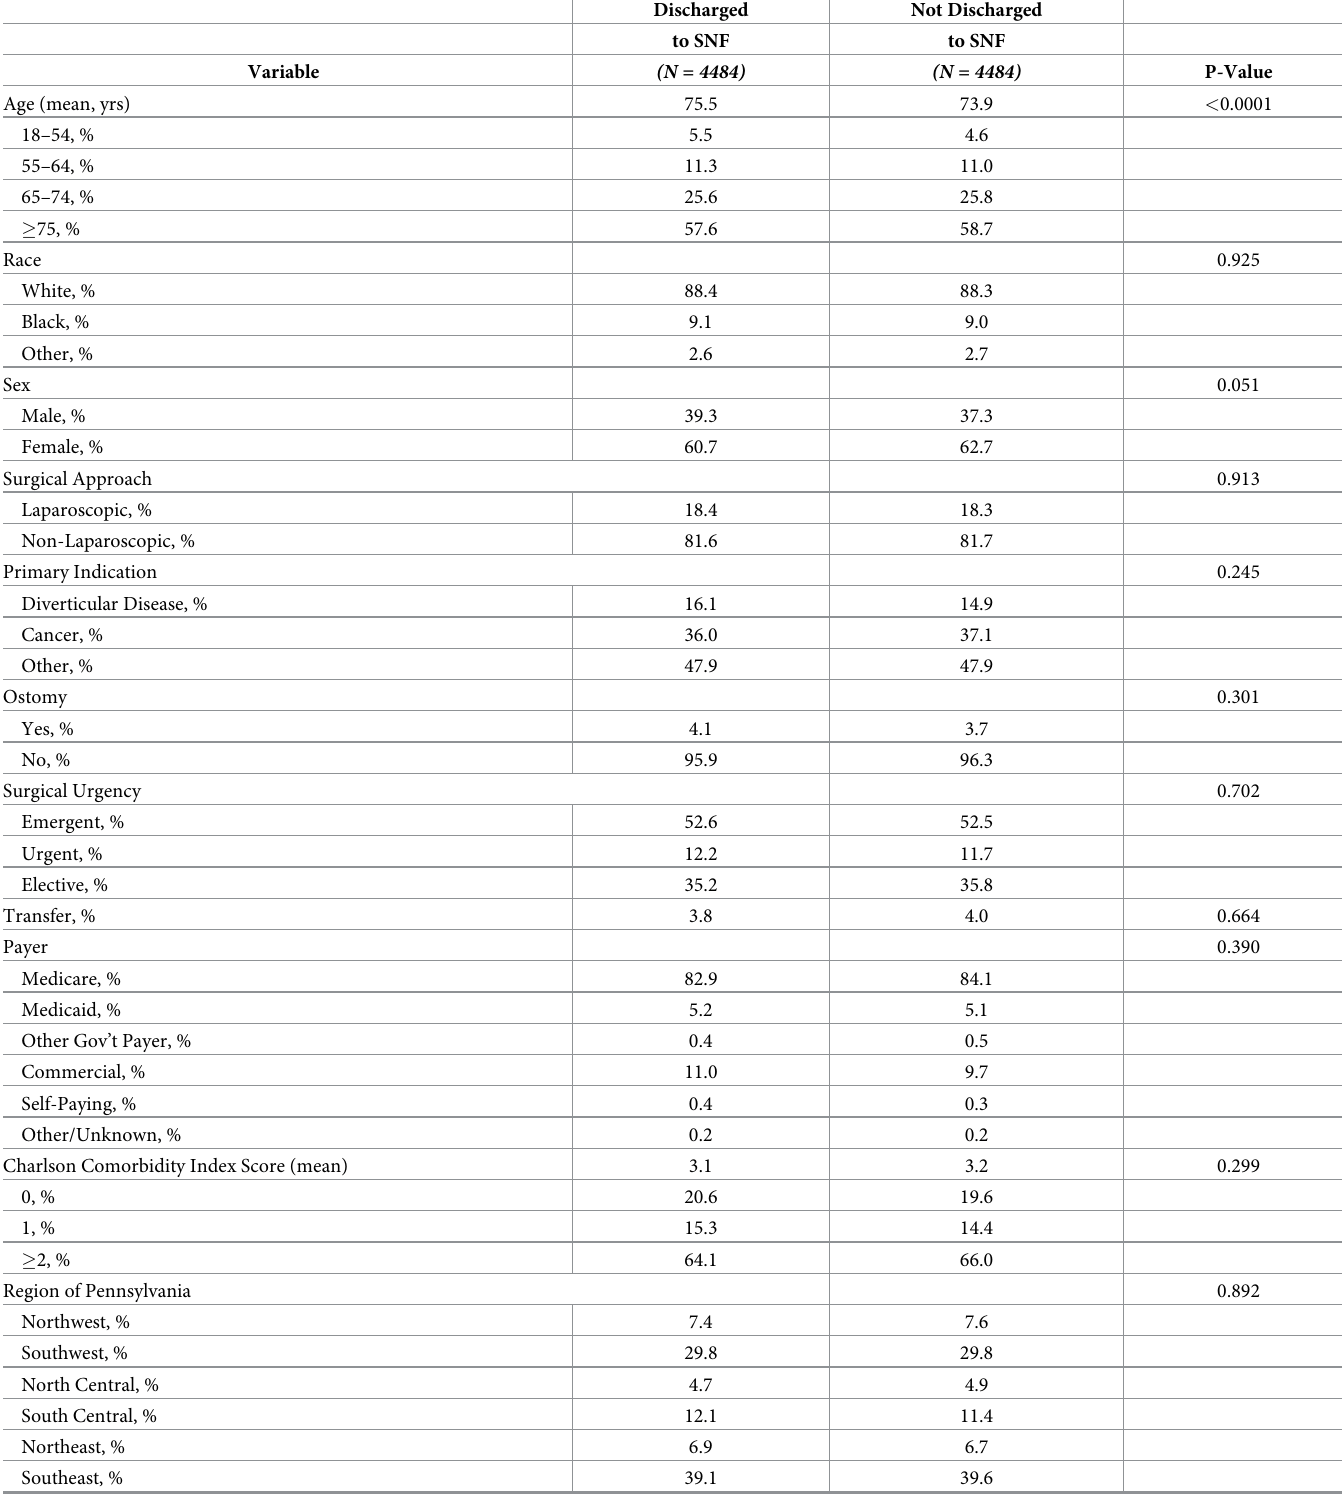
Table 2. Demographic characteristics for the matched colectomy cohort, stratified by discharge to SNF (matched